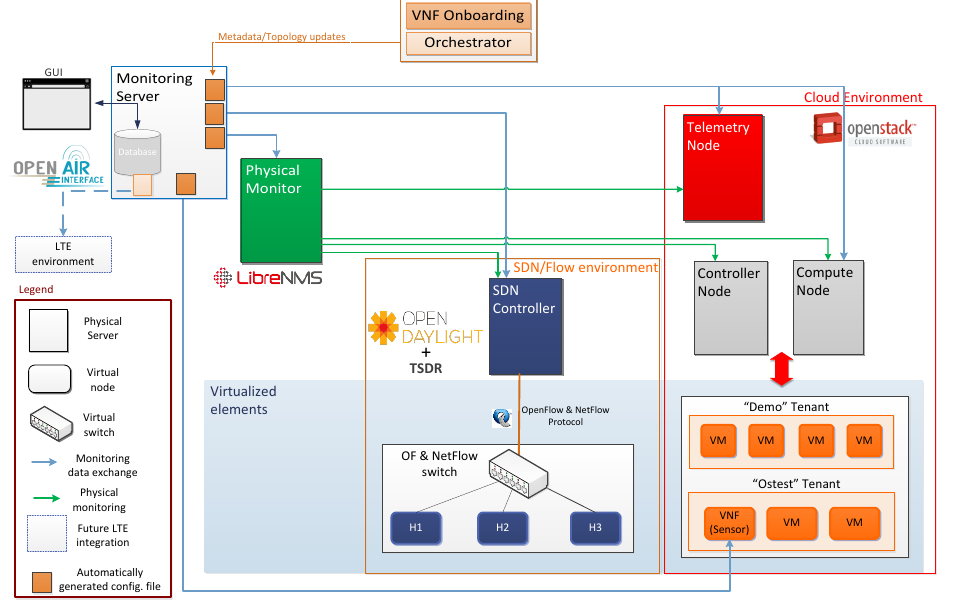
Figure 16. SELFNET Monitoring Framework Testbed.